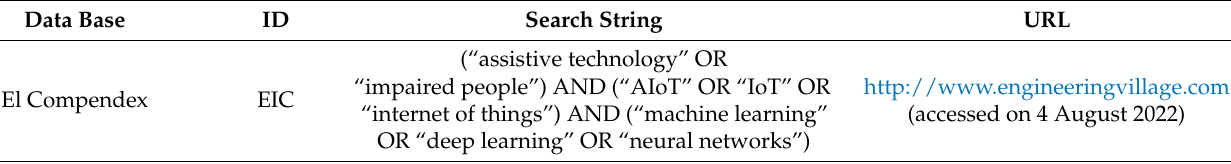
Table 2. Databases and search strings.